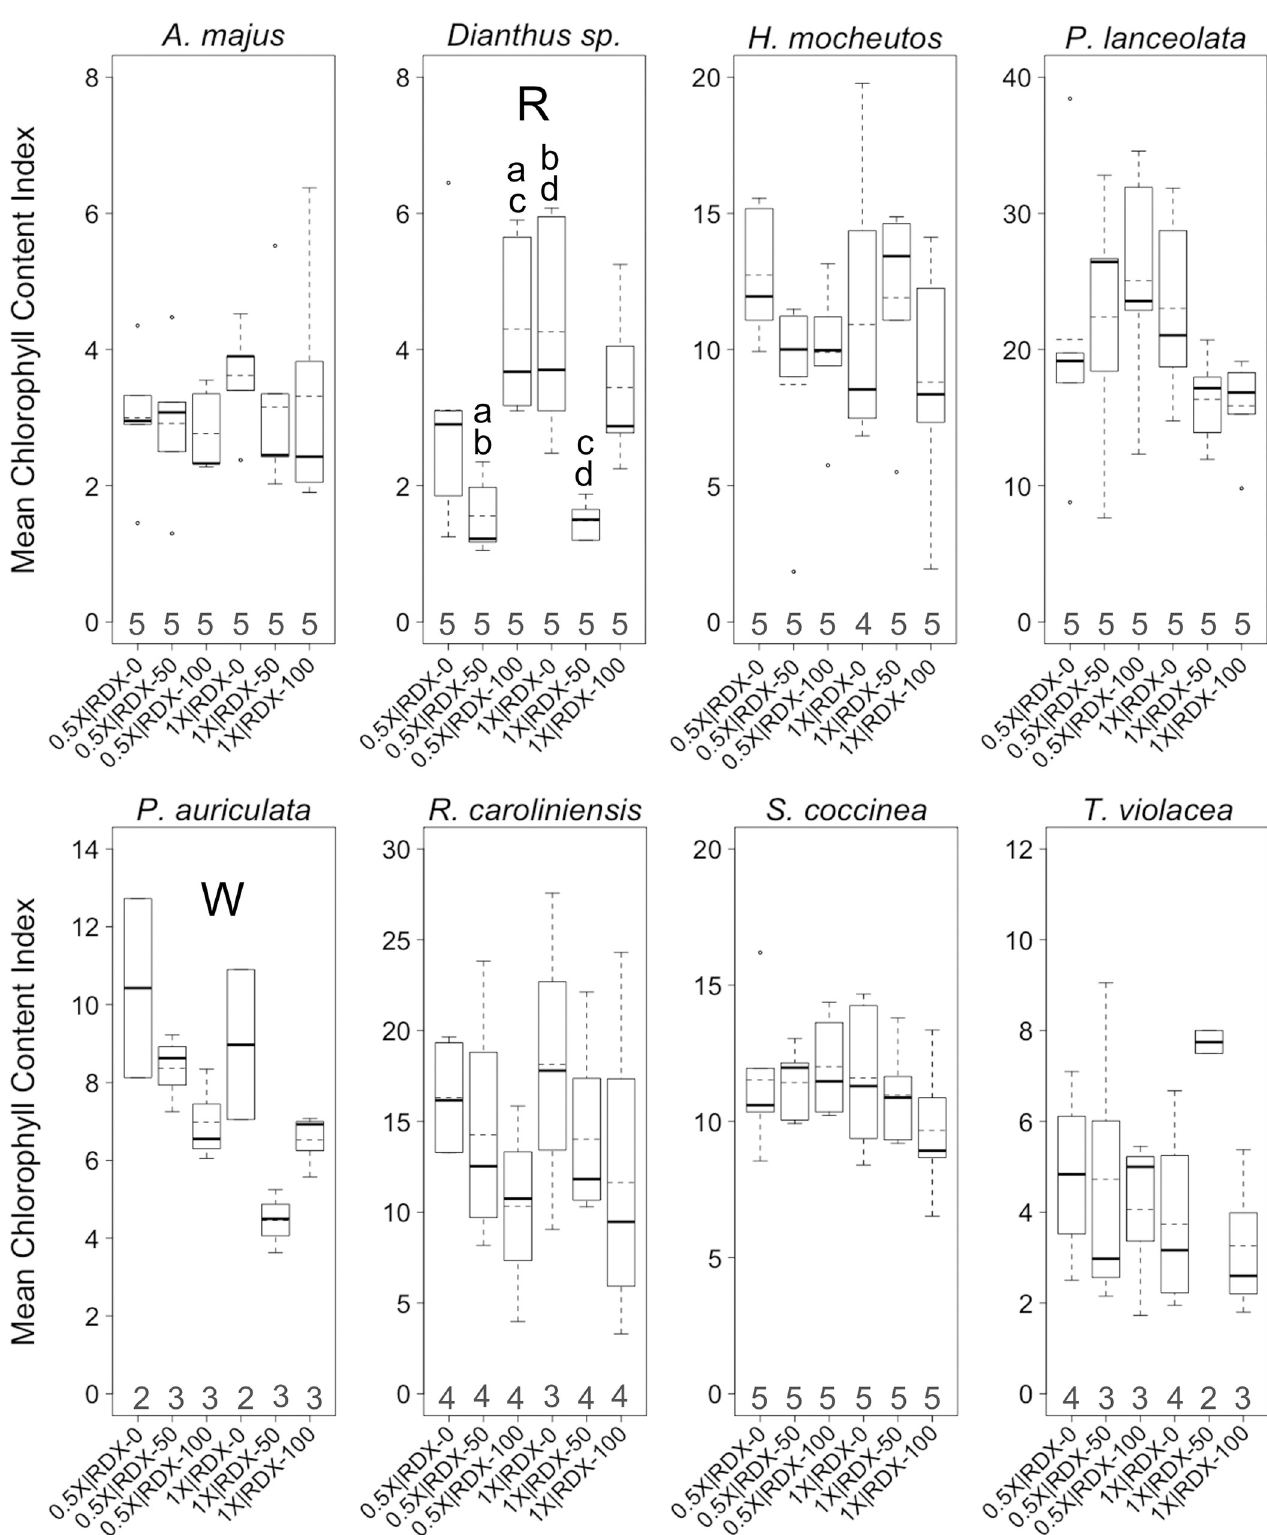
Fig 6. Chlorophyll content index levels in greenhouse trials. Boxplots of mean chlorophyll content index ( CCI ) levels per plant across eight plant species. Plants were reared in a greenhouse under different combinations of two factors, water-resourcing level (1X and 0.5X) and soil RDX concentration (0, 50, and